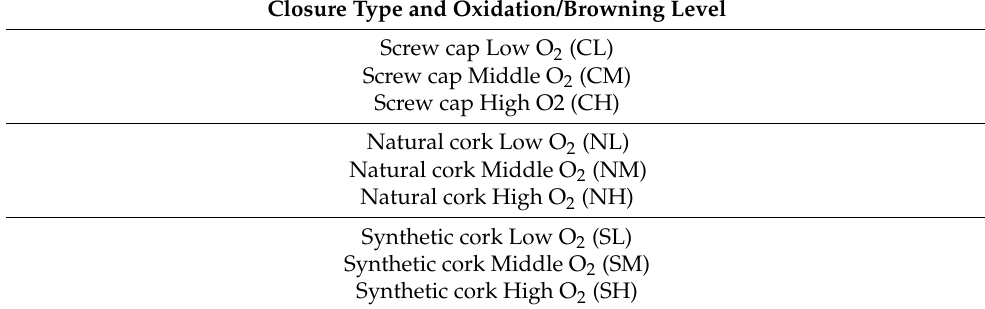
Table 3. Closures evaluated in